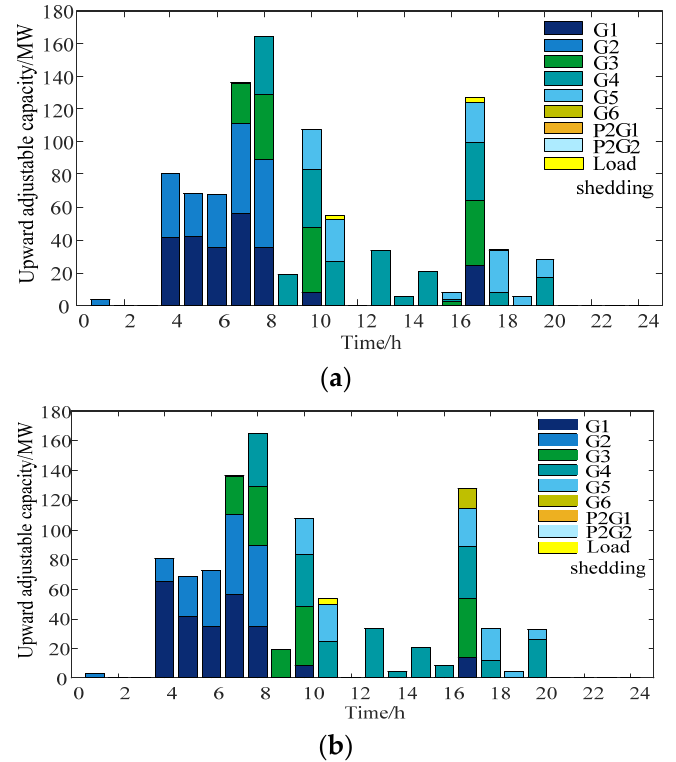
Figure 10. Power system upward adjustable capacity in different dispatch modes: ( a ) Separate optimization and ( b ) Coordinated optimization.